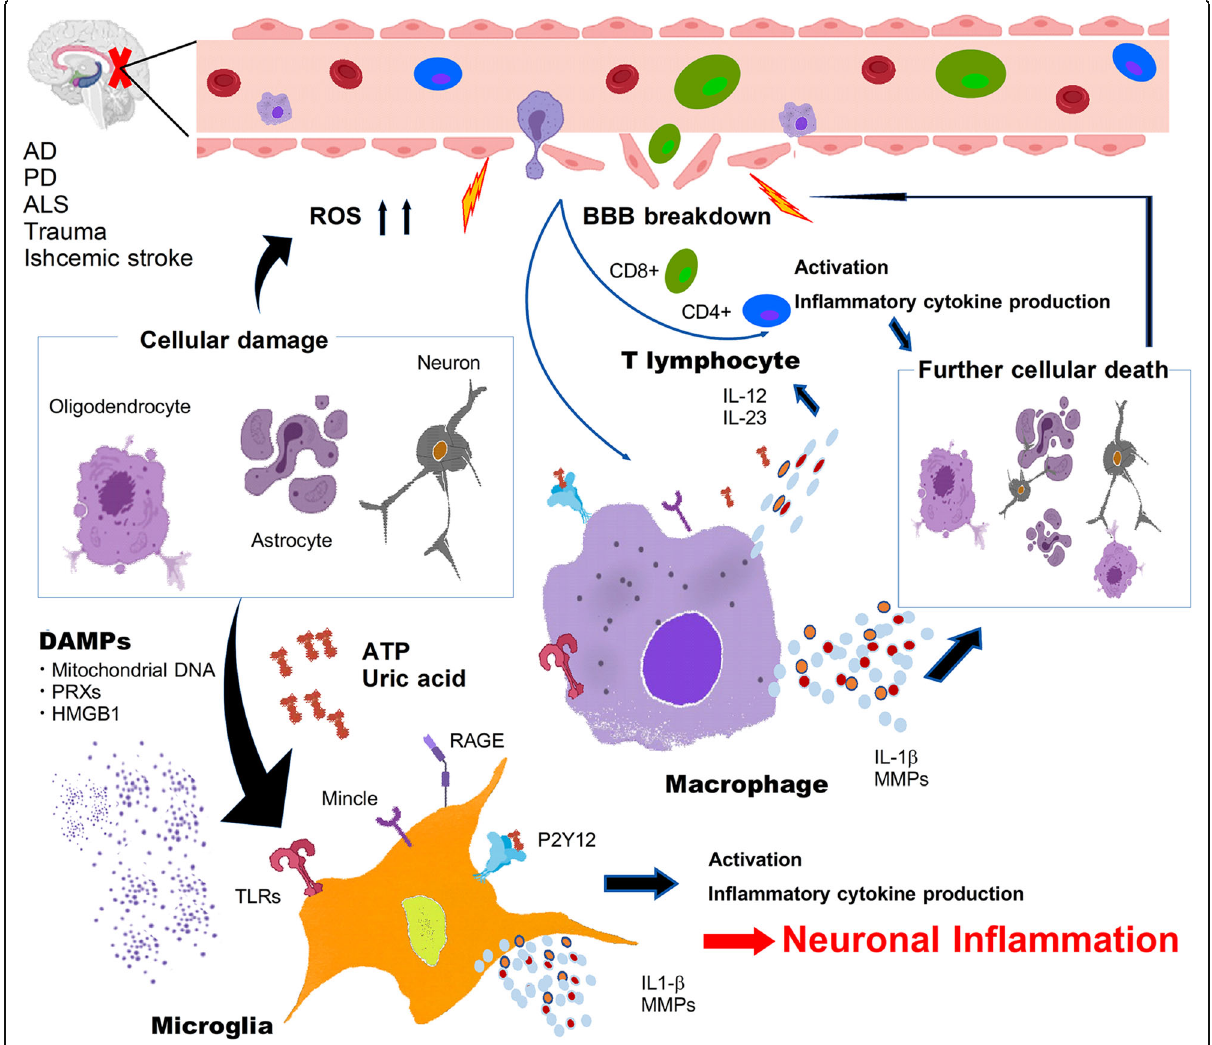
Fig. 1 Induction of sterile neuroinflammation. ATP, uric acid, and other DAMPs released from the damaged cells activate microglia and macrophages infiltrating through disrupted BBB. Activated microglia and macrophages produce inflammatory cytokines including the activator of infiltrating T lymphocytes, resulting in the sustained neuroinflammation that leads to further cell death and progression of CNS